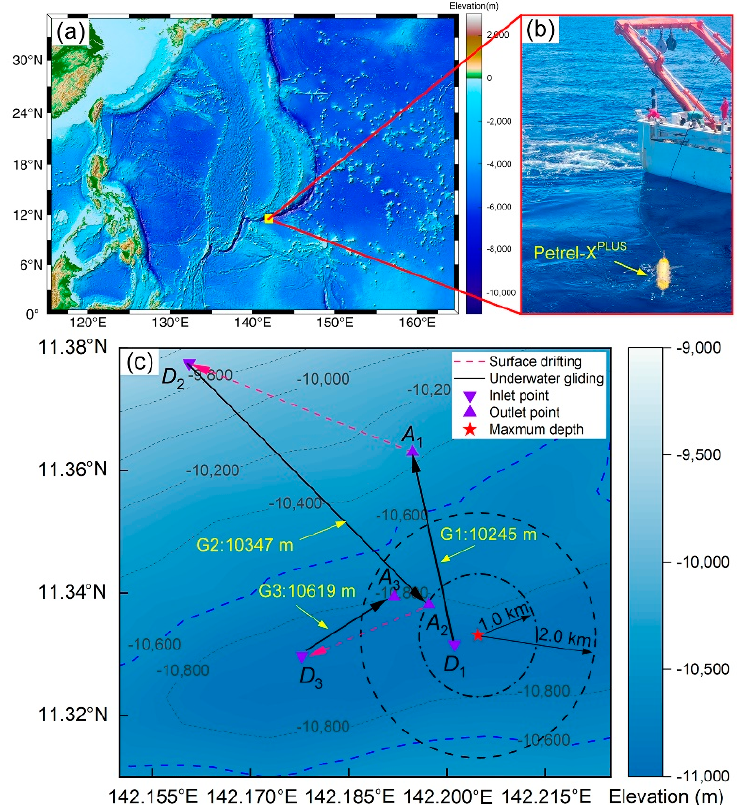
Figure 19. Sea trial of Petrel-X PLUS in Mariana Trench: ( a ) Sea trial area; ( b ) Petrel-X PLUS in the sea trial; ( c ) The navigation trajectory.